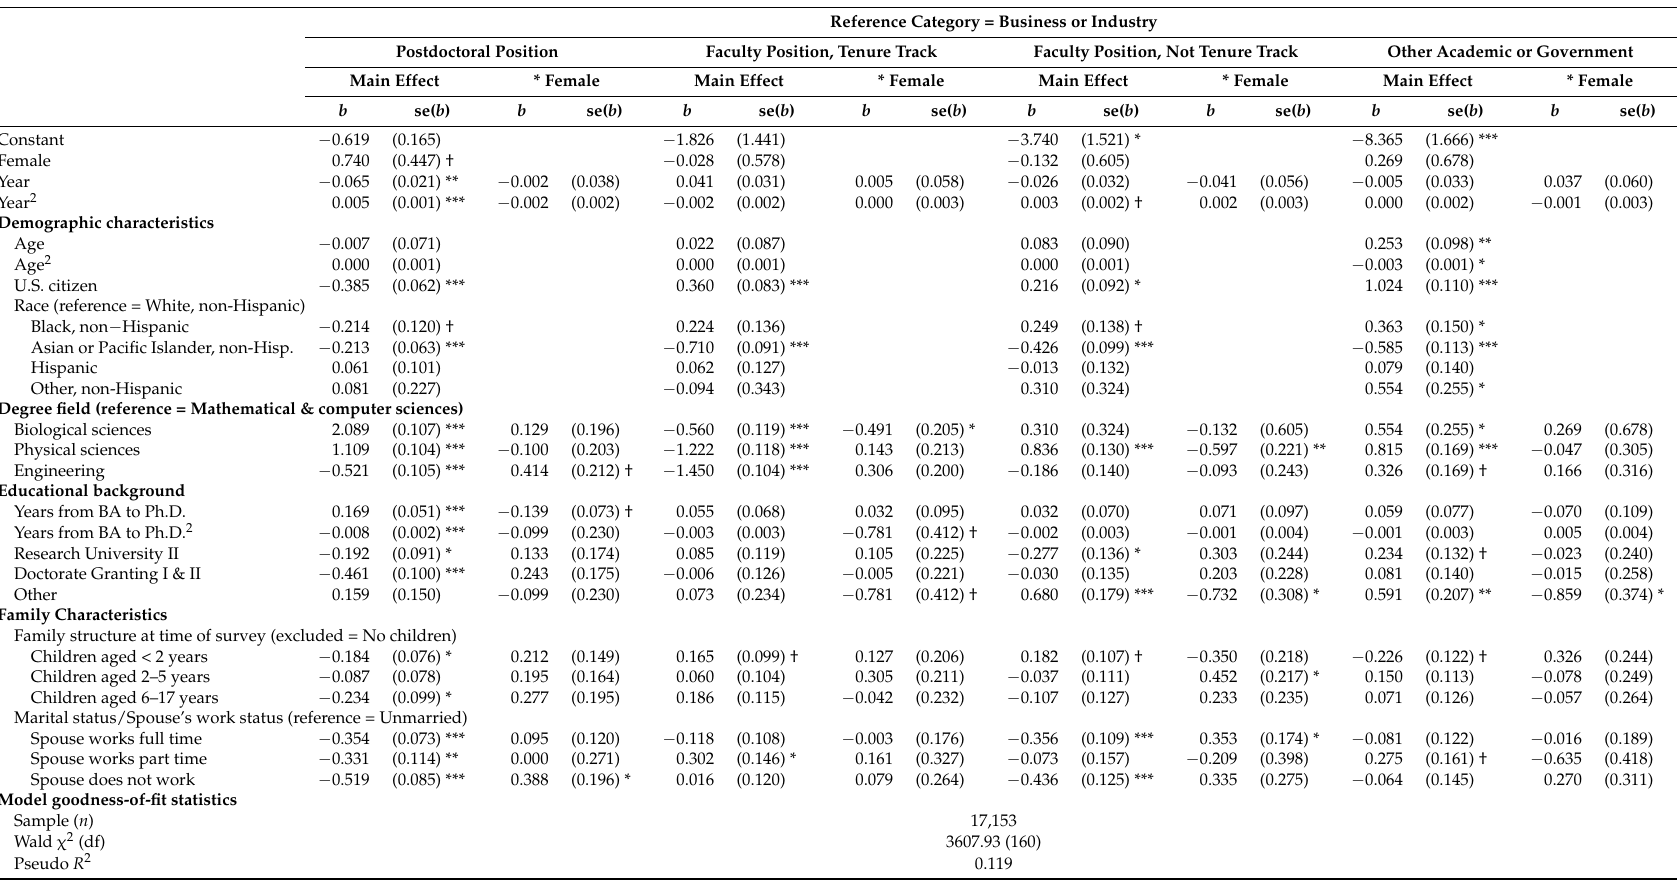
Table A3. Estimated coefficients from multinomial logit models of employment